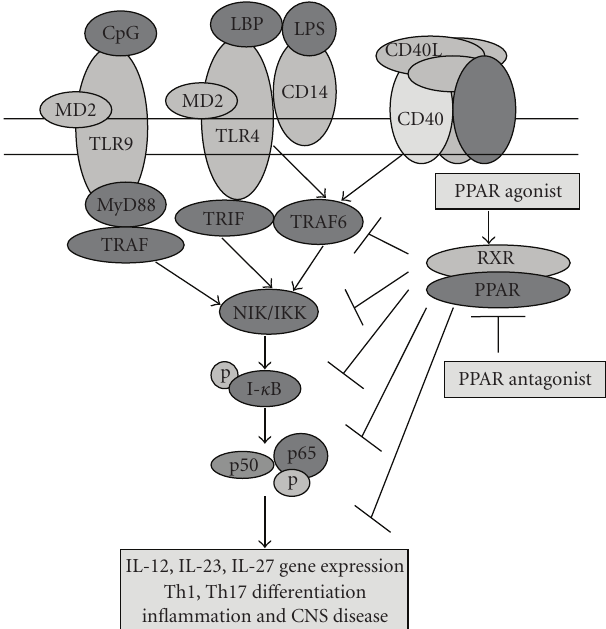
Figure 3: Regulation of NF- κ B pathway by PPAR agonists in CNS diseases. The activation of microglia, macrophage and dendritic cells through toll-like receptor, CD40 or cytokine associated NF- κ B pathway leads to secretion of inflammatory cytokines leading to pathogenesis of CNS diseases. PPAR agonists inhibit NF- κ B pathway resulting in inhibition of CNS